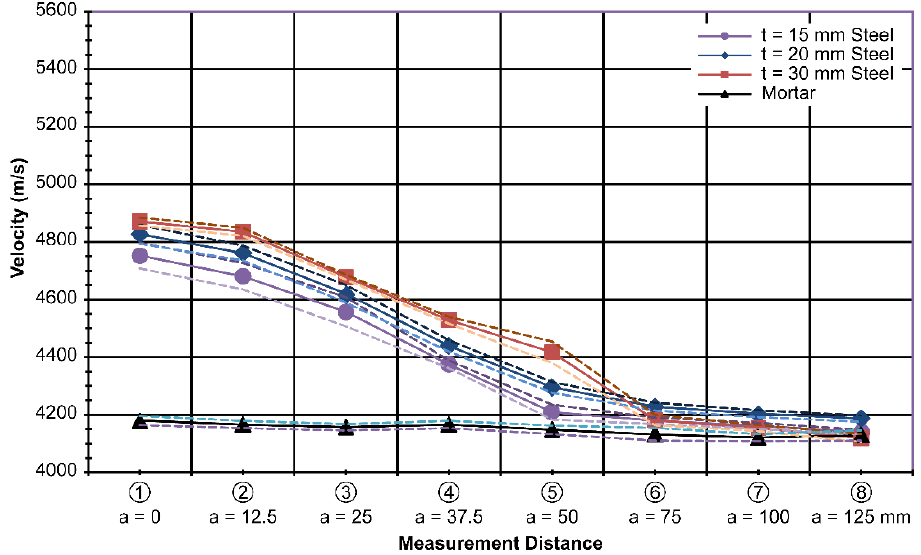
Figure 7. Measured velocity with varying thickness (t)at d = 75 mm and h = 150 mm.